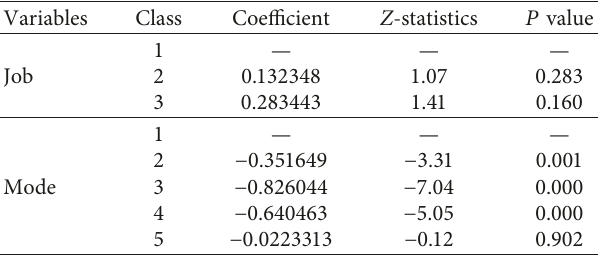
Table 8: Statistics of related variables in each class.